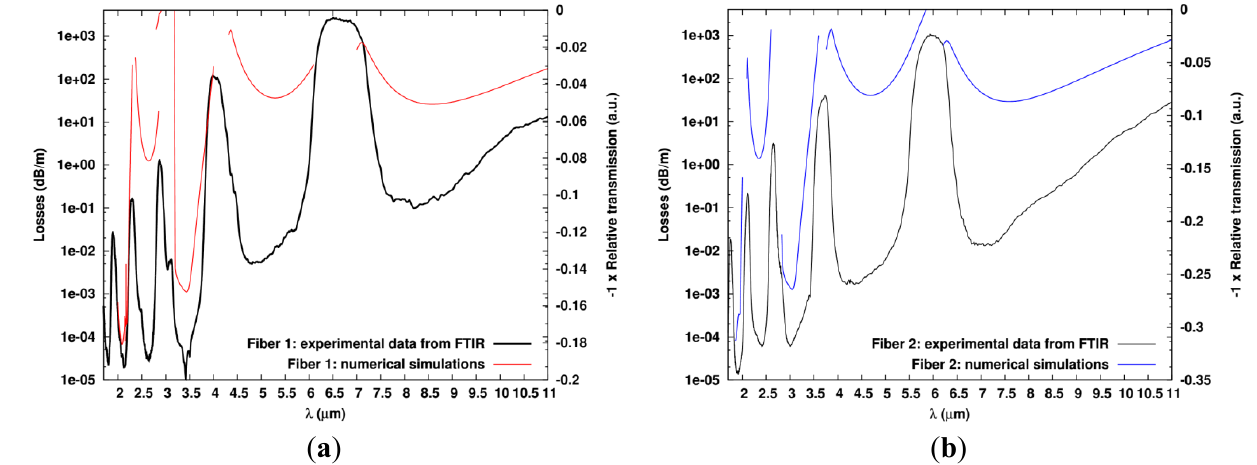
Figure 7. Computed guiding losses (without taking into account any material losses) in dB/m with a log-scale (left y -axis) and sign-reverse of the measured relative transmission in arbitrary unit (right y -axis) vs. the wavelength: for the ( a ) Fiber 1; and ( b ) Fiber